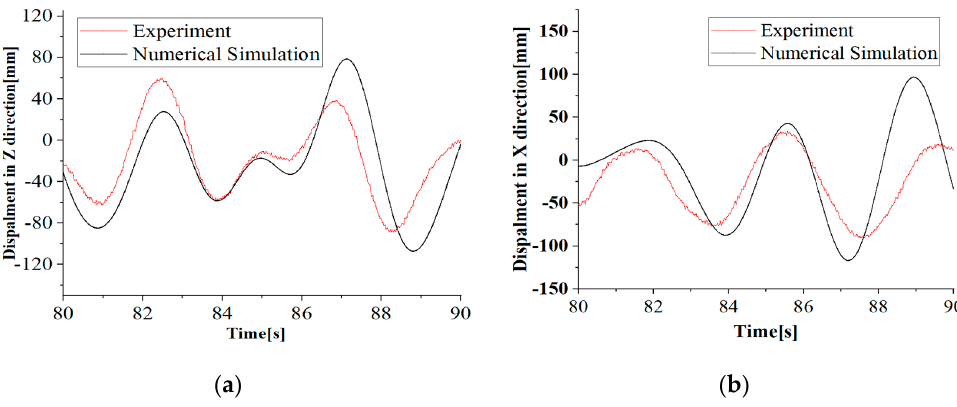
Figure 35. Comparison between numerical simulation and experiment at LC4. ( a ) Heave; ( b ) surge. The numerical simulation data were converted by a certain scale ratio and compared with the test data, as shown in Table 9. Table 9. Summary of simulation and experiment results